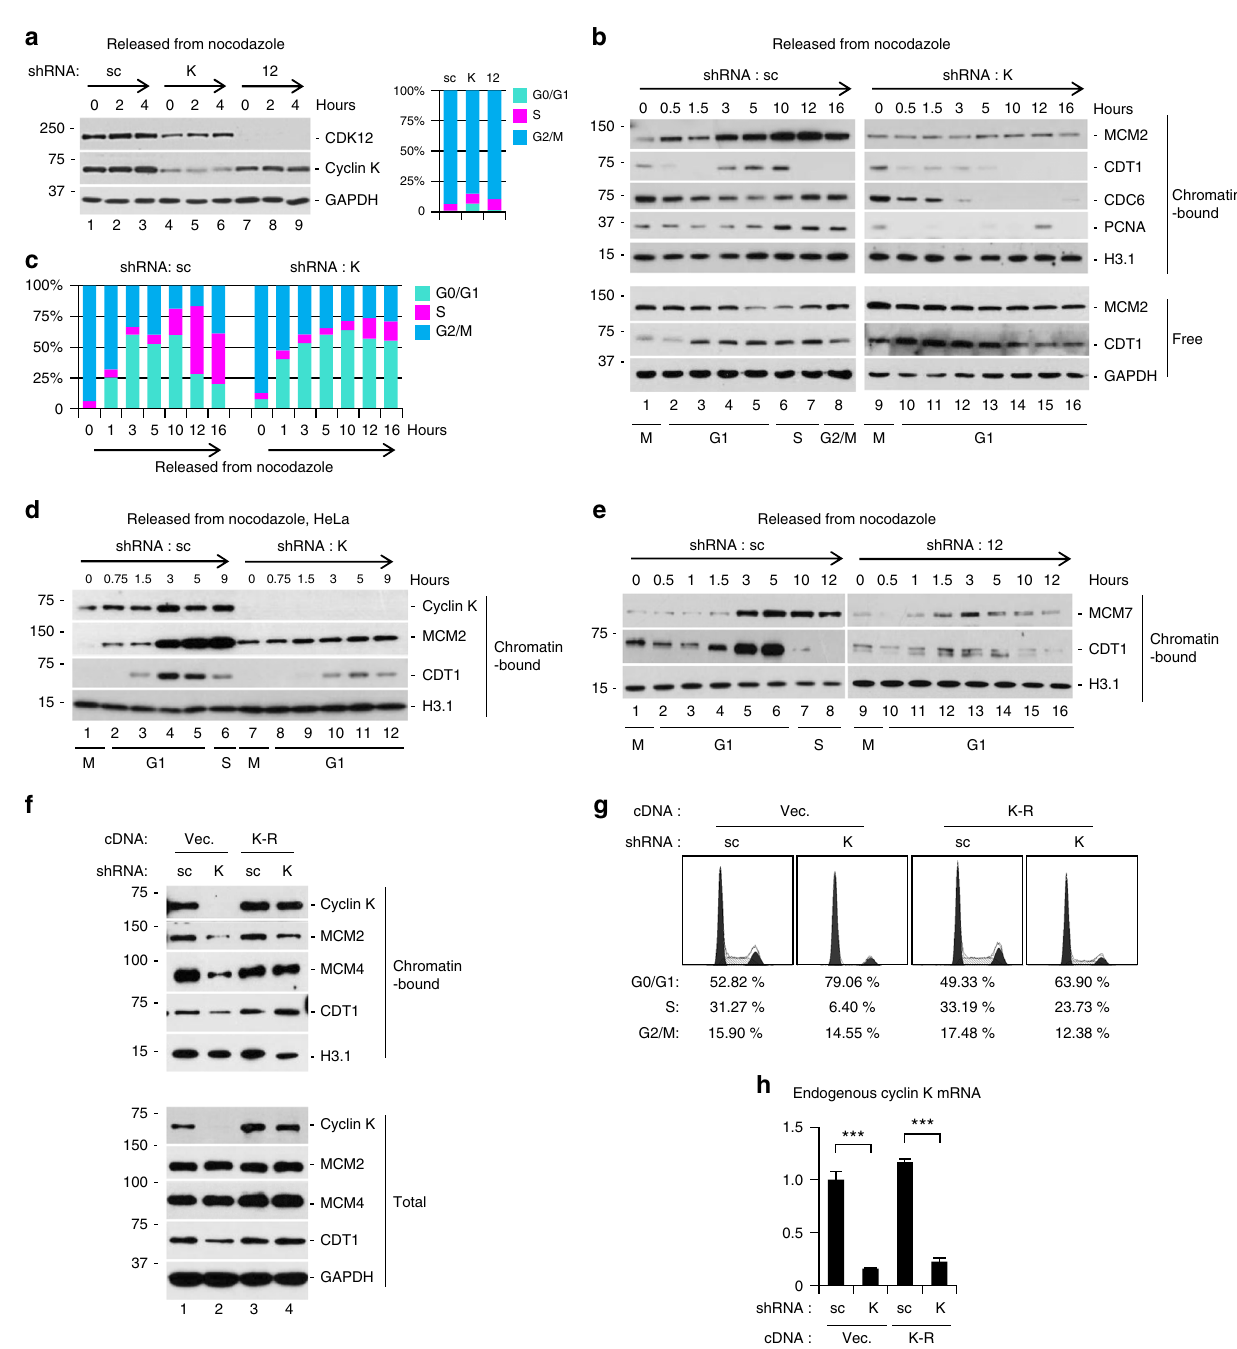
Fig. 4 Cyclin K is required for pre-RC assembly. a HCT116 cells were knocked down by indicated shRNA for 2 days and synchronized at M phase using procedure described in Fig. 2j, k. A portion of cells were used for protein blotting analysis (left panel), and the rest for FACS analyses (right panel). 0 h denoted cells collected immediately after release into fresh medium without nocodazole (800 ng/ml). b Sequential loading of prereplicative complex constituents (CDC6 followed by CDT1 and fi nally MCM2) onto chromatin in HCT116 cells from a were analyzed. Chromatin-bound PCNA marked S phase entry. Corresponding cell cycle phases were labeled at the bottom on basis of FACS analysis in c . c An aliquot of cells from b at each time point were analyzed by FACS analysis to demarcate each cell cycle phase. d Similar experiment as in b using HeLa cells. e Sequential loading of prereplicative complex constituents (CDT1 and MCM7) onto chromatin with or without CDK12 knockdown in HCT116 cells. f Rescue of pre-RC assembly defect by shRNA- resistant cDNA encoding cyclin K (K-R). cDNA was transduced into HCT116 cells, followed by transduction of shRNA 12 h later. vec., vector control. g Rescue of cell cycle defect by shRNA-resistant cyclin K in HCT116 cells. h An aliquot of HCT116 cells from f were used to determine the level of endogenous cyclin K transcript by qPCR analysis. Data are means ± SEM ( n = 3) (*** p < 0.001; Student ’ s t -test). All experiments were repeated at least three times and representative results are